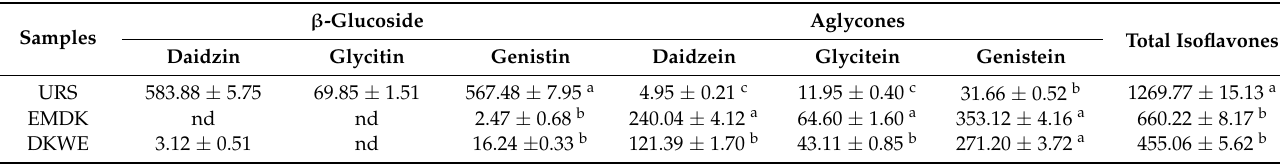
Table 4. The contents of isoflavones ( µ g/g dry